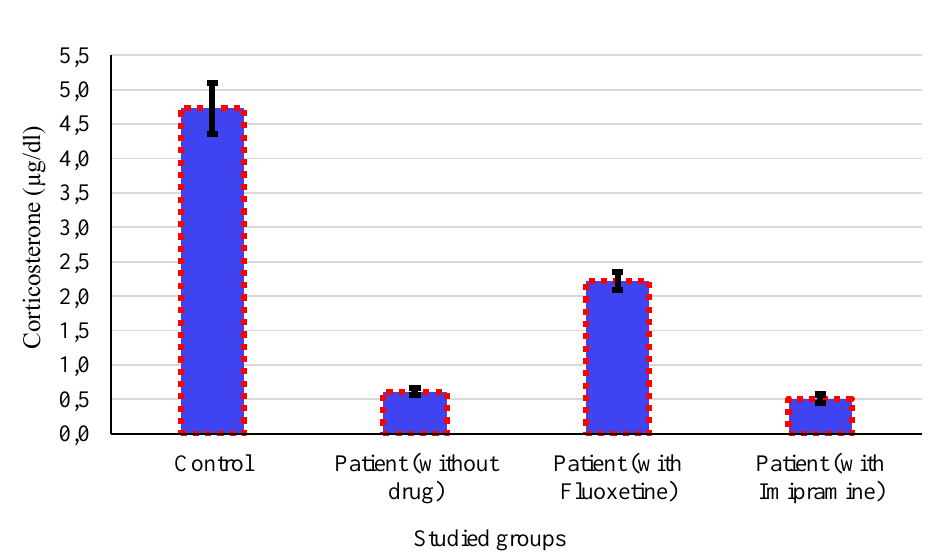
Fig. 6. Comparison of the corticosterone amount between studied groups